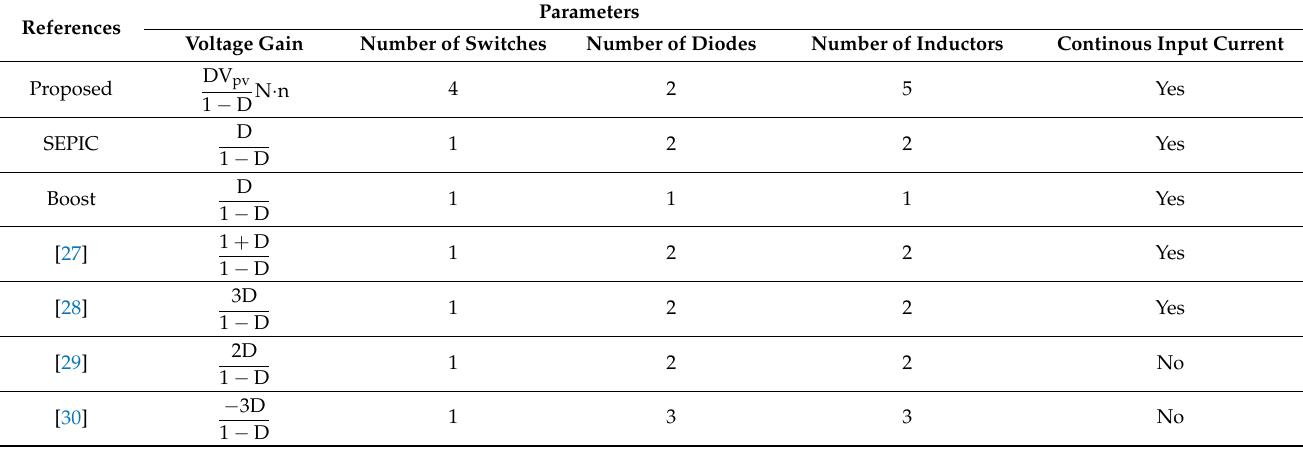
Table 2. Comparison between the proposed converter and some other